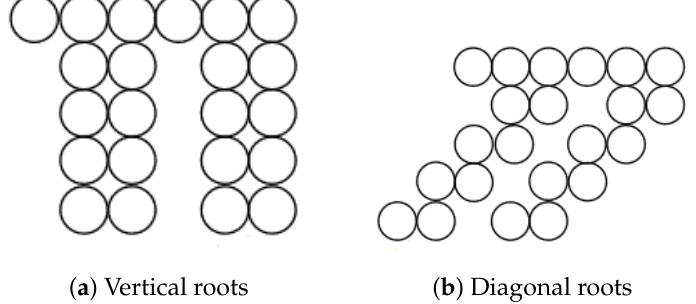
Figure 17. Roots in pyramid p 6 q . We show all activated vertices except those above the primary vertices of pyramid p 6 q